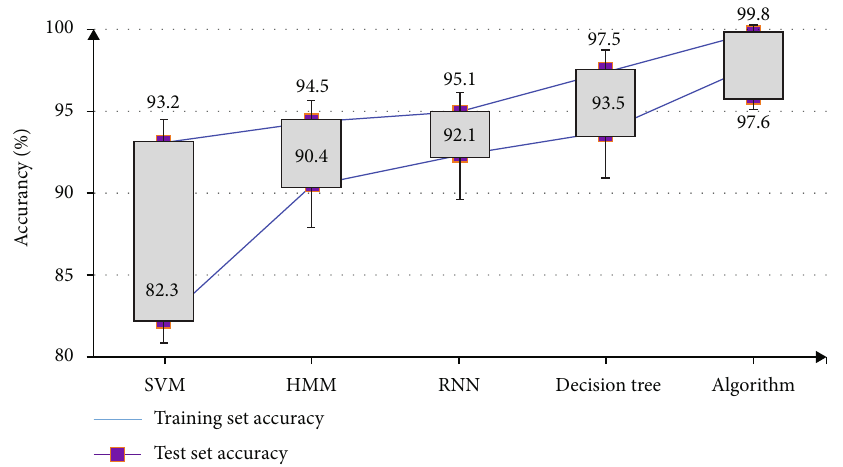
Figure 2: Multi-information fusion